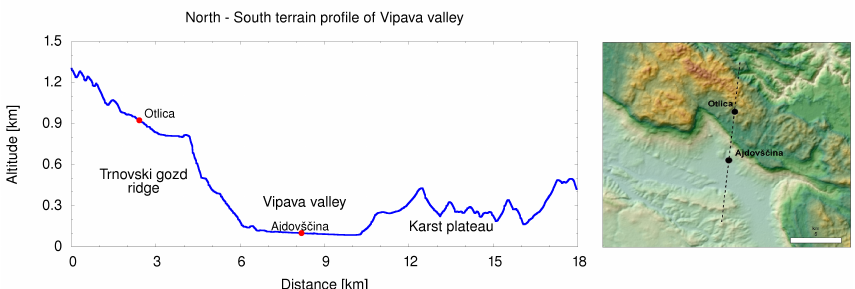
Figure 1. Terrain configuration of study region. The study stations are marked by the red points, including the Trnovo plateau, the Vipava valley and the Karst